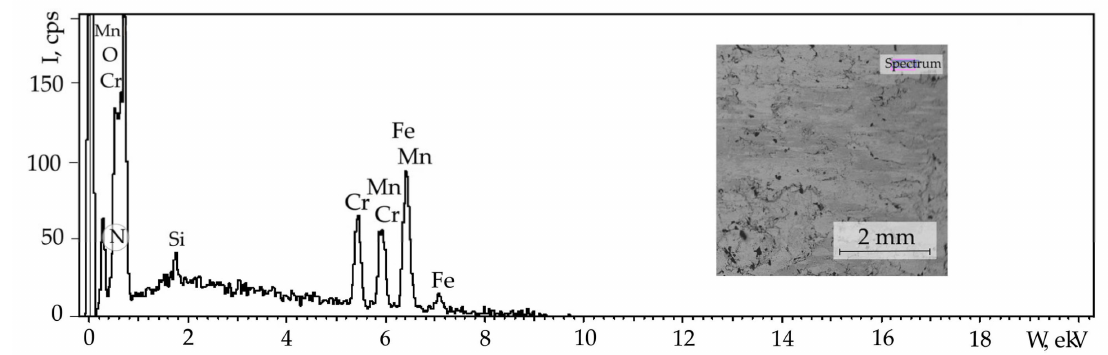
Figure 7. Spectra (with energy dispersion) of characteristic X-ray radiation of surface elements of the P900 high-nitrogen steel.